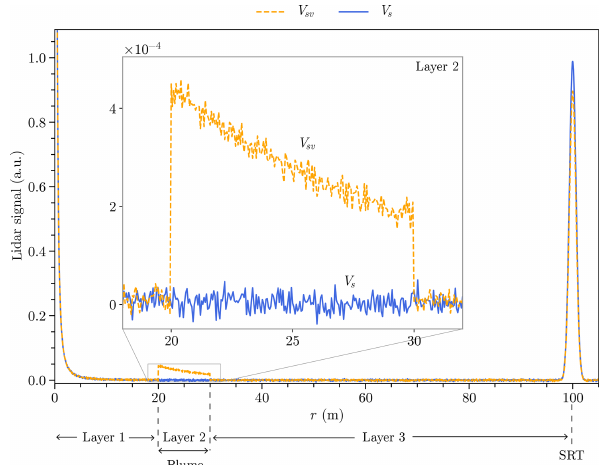
Figure 3. Theoretical noised lidar signals from a SRT V s (blue line) and in the presence of an aerosol plume V sv (orange dashed line). Simulations have been performed at 532nm with molecular and continental aerosol background